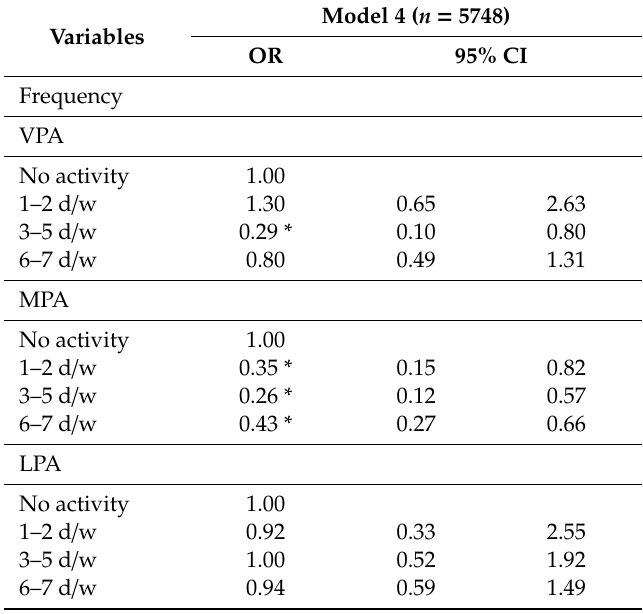
Table A1. Associations between PA and the risk of PA (excluding participants with